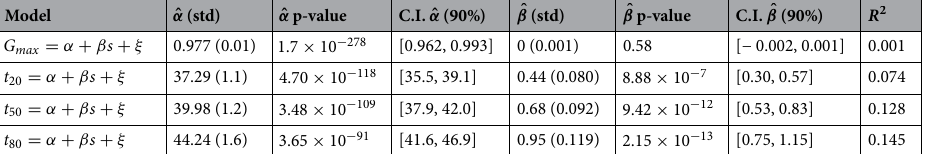
Table 2. Evaluation of the the impact of the number of seeds ( s ) on four physiological indices ( G max , t 20 , t 50 and t 80 ) was achieved by linear regression estimations by ordinary least square analysis. The column Model defines the estimated linear regression where ξ is a Gaussian noise, α is the intercept and β the slope of the ˆ β model. Estimated value of the intercept ( ˆ α ) and the slope ( ) are shown with their standard error values in bracket. Two-sided p-values against the null hypotheses that the coefficients α and β are null are shown. 2 The 90% symmetrical confidence intervals (C.I.) of each coefficient are displayed. The R values of the linear models are listed.